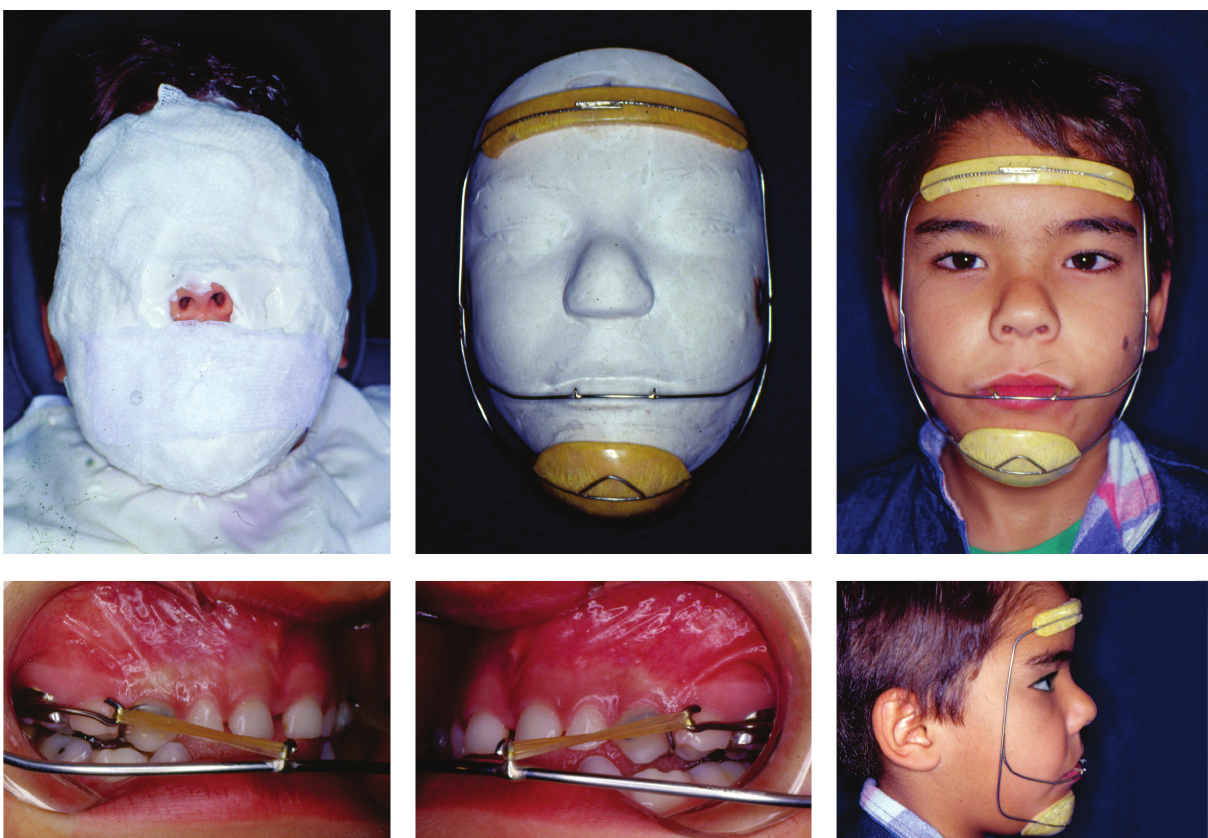
Figure 3- Photographs of the construction and adaptation of Turley´s face mask. Parents authorized the publication of these pictures.